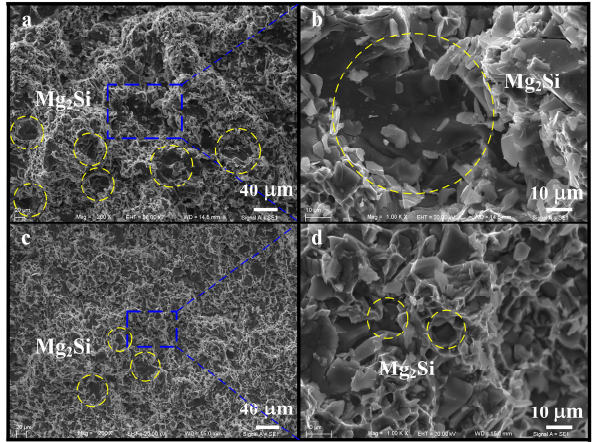
Figure 6. The SEM fracture morphology of hot-extruded and T6 treated alloys tensile at room temperature: ( a , b ) Al–18Mg 2 Si–4.5Cu; ( c , d ) Al–18Mg 2 Si–4.5Cu–0.2(Sr–Sb). (In yellow circles are primary Mg 2 Si particles)